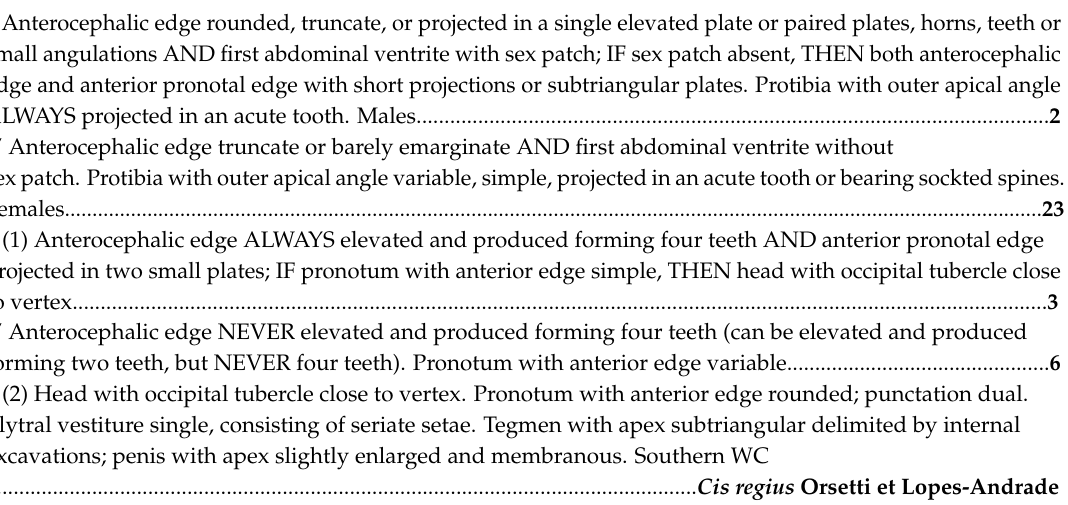
1 Anterocephalic edge rounded, truncate, or projected in a single elevated plate or paired plates, horns, teeth or small angulations AND first abdominal ventrite with sex patch; IF sex patch absent, THEN both anterocephalic edge and anterior pronotal edge with short projections or subtriangular plates. Protibia with outer apical angle